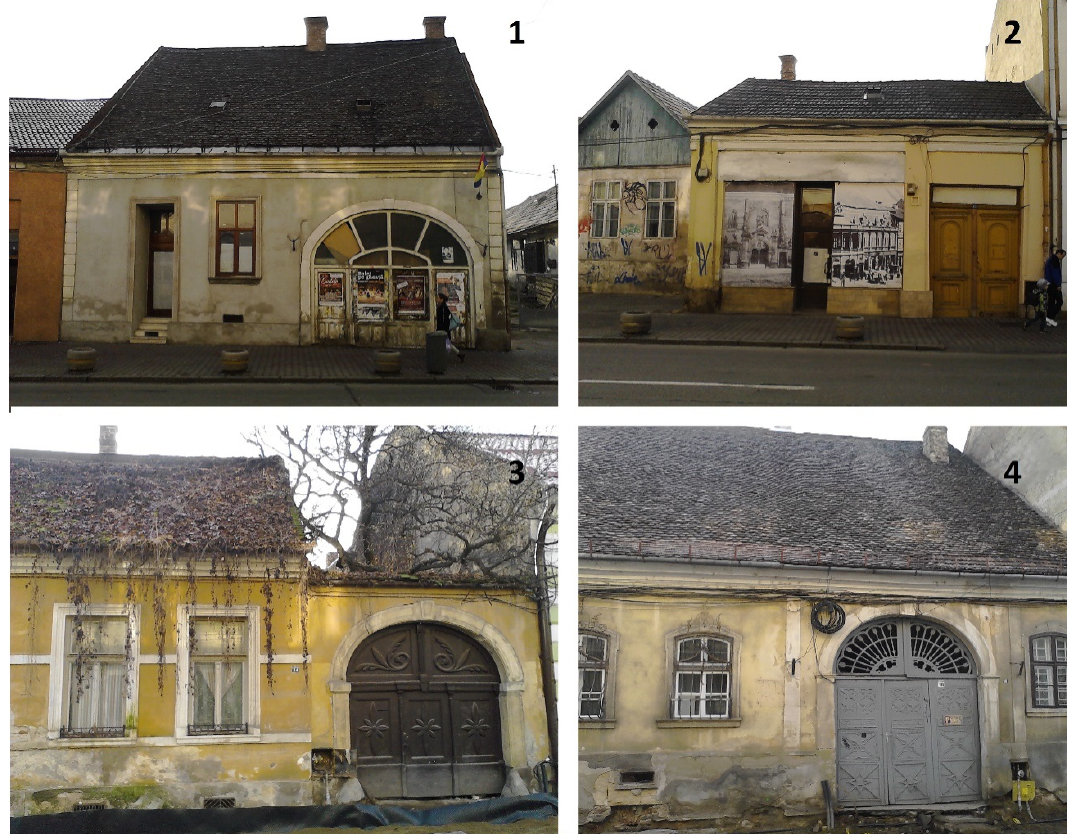
Figure 2 3 : Degraded historical buildings. 1, 2 - Nearby Lucian Blaga Square and 3, 4 - Nearby Avram Iancu Square Source: Zoltan MAROȘI ,